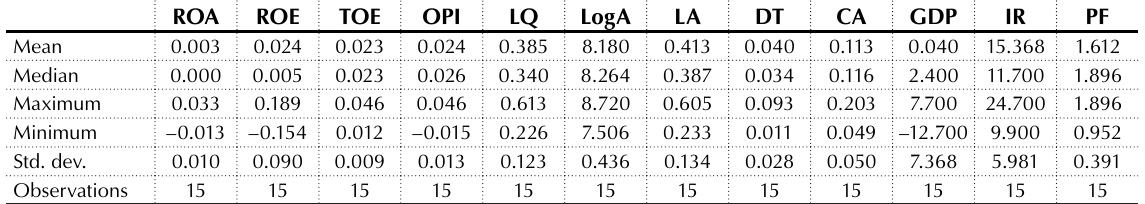
Table 2. Descriptive summary of the study variables